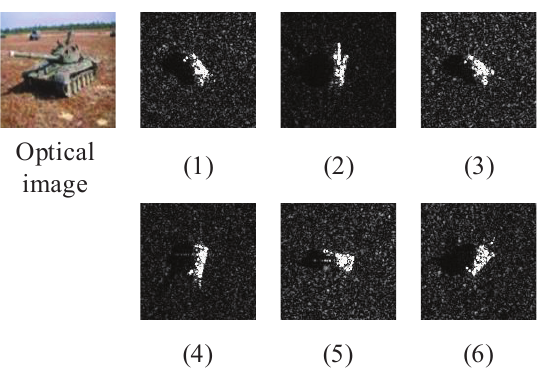
Figure 1. Comparison of the same target’s SAR images in different azimuth angles. Sub-figures (1)–(6) are SAR images of T72 tank in different azimuth